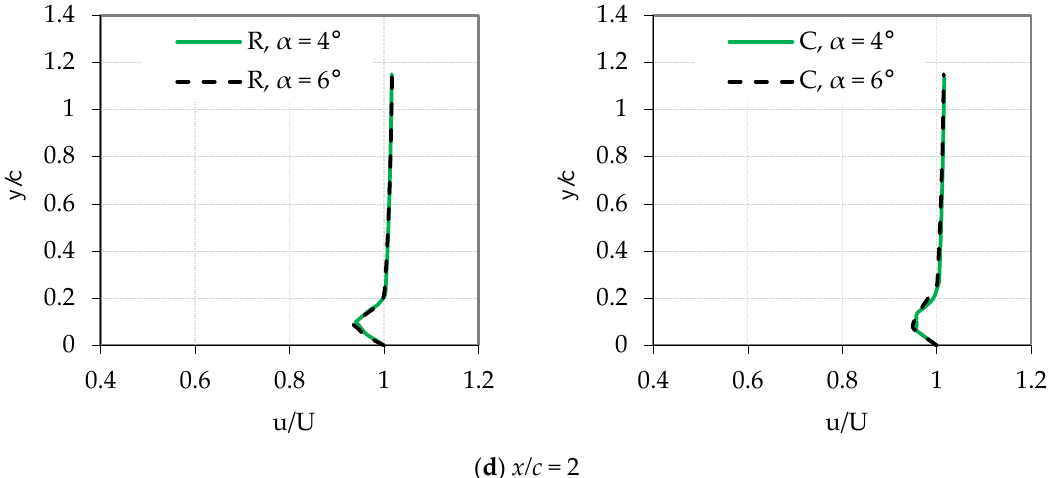
Figure 10. Distribution of the velocity at the middle span in the wake region behind the Compound wing (C) and the Rectangular wing (R) at ( a ) x/c = 1.05, ( b ) x/c = 1.25, ( c ) x/c = 1. 5 and ( d ) x/c = 2.0 for h/c = 0.15 and various angles of attack ( α ). Table 3. Maximum velocity deficiency in the wake area in the back of the compound and the rectangular wing.